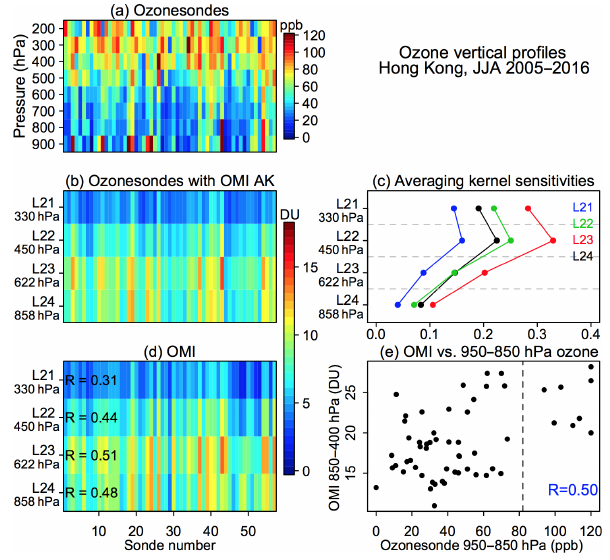
Figure 3. Ozone vertical profiles over Hong Kong in summer (JJA) 2015–2016. (a) Ozonesonde data coincident with OMI observations ( n = 57), averaged over a 100hPa grid and arranged in chrono- logical order. (b) The same ozonesonde data but smoothed by the OMI averaging kernels. Mean pressures for each OMI retrieval level are indicated. (c) Mean averaging kernel sensitivities for each OMI retrieval level, as described by the rows of the averaging kernel matrix; values are shown for August 2015 but are similar in other summer months and years. The dashed lines are bound- aries between retrieval levels. (d) OMI ozone observations coinci- dent with the ozonesondes. The correlations of unsmoothed 950– 850hPa ozonesonde data with the OMI retrievals for different lev- els are shown inset. (e) Relationship of unsmoothed 950–850hPa ozonesonde data and OMI 850–400hPa ozone. The correlation is shown inset. The dashed line corresponds to the Chinese ozone air quality standard (82ppb).